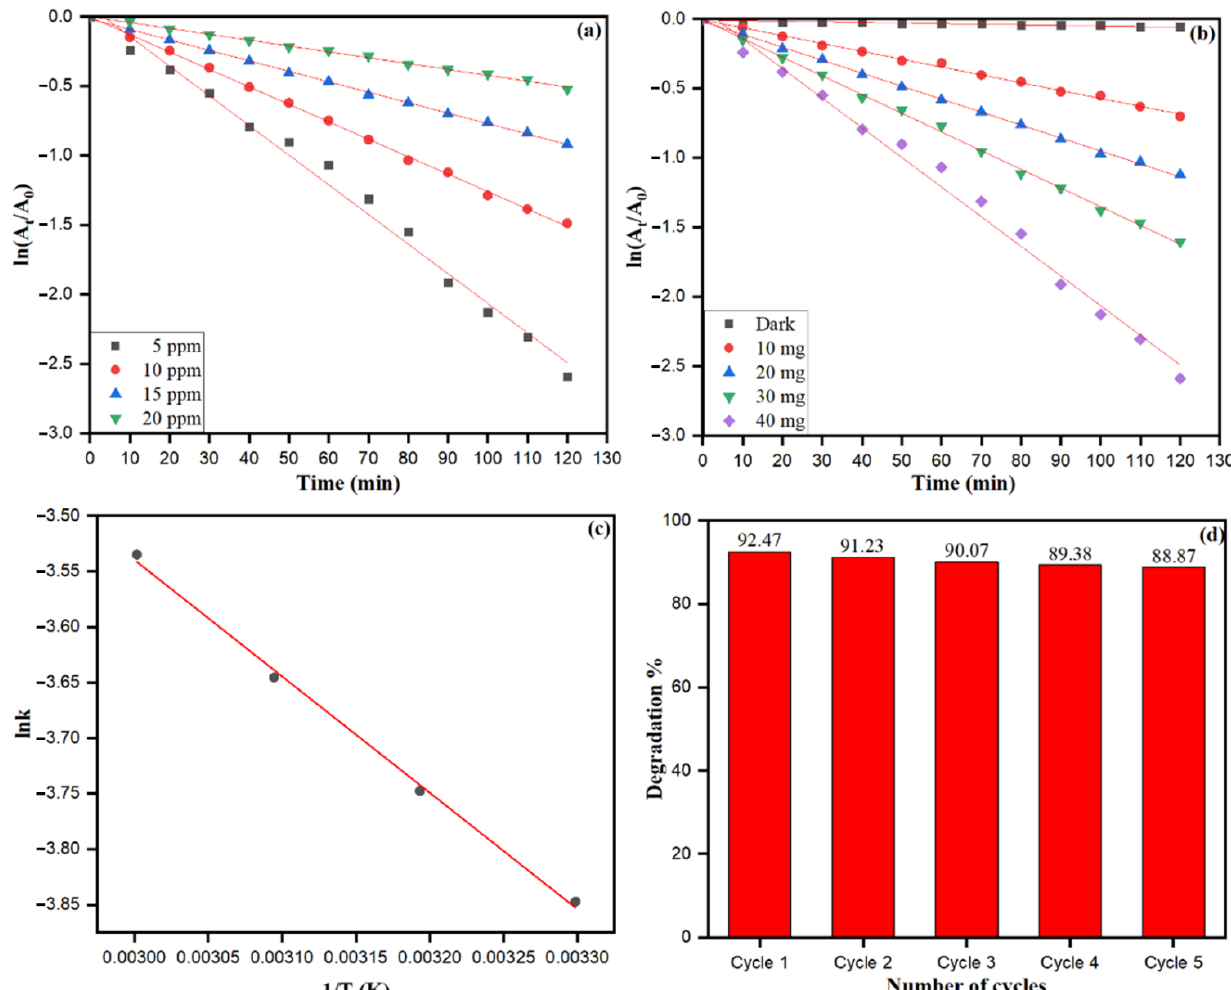
Figure 12. The plot of ln [ A t ] vs. irradiation time for the MO dye degradation by bio-fabricated ZnONPs ( a ) at different dye concentrations, ( b ) at different amounts of ZnONPs, ( c ) Arrhenius plot (lnk vs. 1/T curve) for MO degradation, ( d ) Effect of recycling of ZnONPs on MO dye degradation.